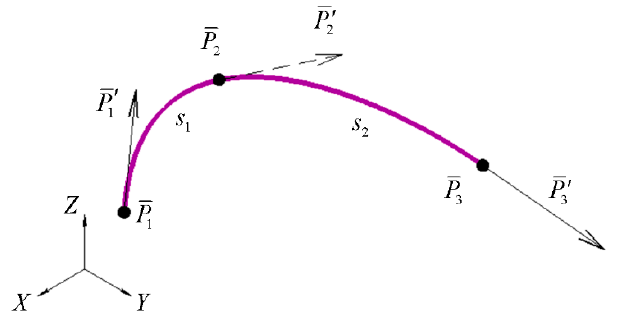
Figure 2. Two-segment Hermite cubic spline curve.